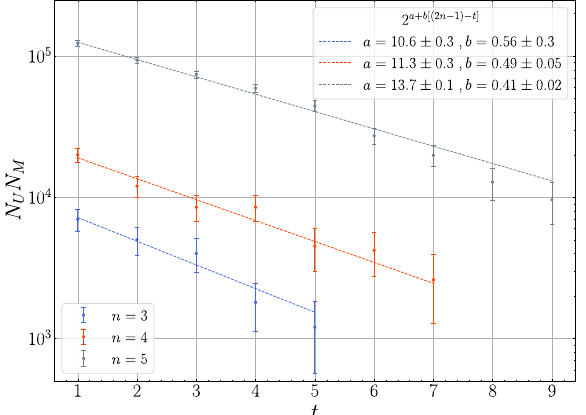
Fig. 7 Number of optimal resources N U and N M . The fi gure shows the log-plot of the optimal number of resources N TOT = N U × N M for n = 3 (blue dots), n = 4 (orange dots) and n = 5 (gray dots) as a function of the number of T -gates t injected in the circuit. The dashed lines represent the fi t N TOT = 2 a + b [(2 n − 1) − t ] ; the values for a and b with the respective errors are reported in the bottom-left corner. The fi tted curves are in perfect agreement with the experimental data, whose error bars are due to the fi nite resolution of the grid: the R -squared parameters are R 2 ¼ 0 : 985 for n = 3, ð 3 Þ R 2 ¼ 0 : 985 for n = 4, and R 2 ¼ 0 : 995 for n = ð 4 Þ ð 5 Þ